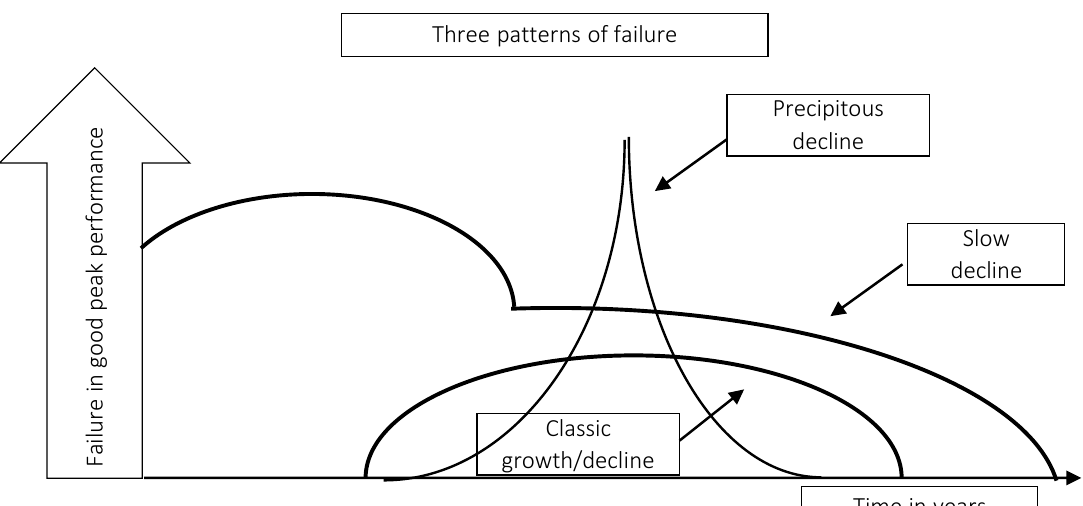
Source: McMillan and Overall